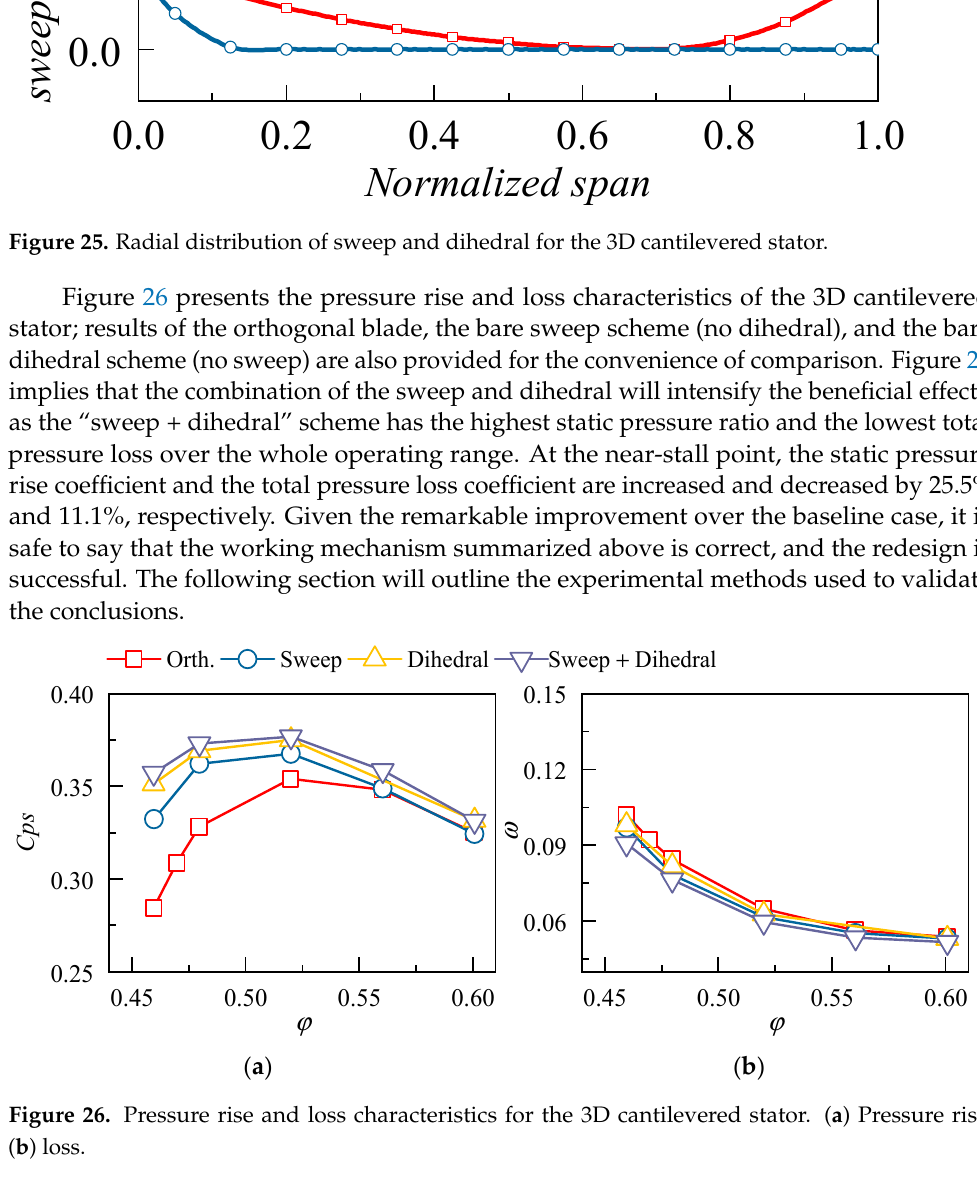
Figure 24. The mechanisms of sweep and dihedral on the cantilevered stator: ( a ) sweep; ( b ) dihedral.